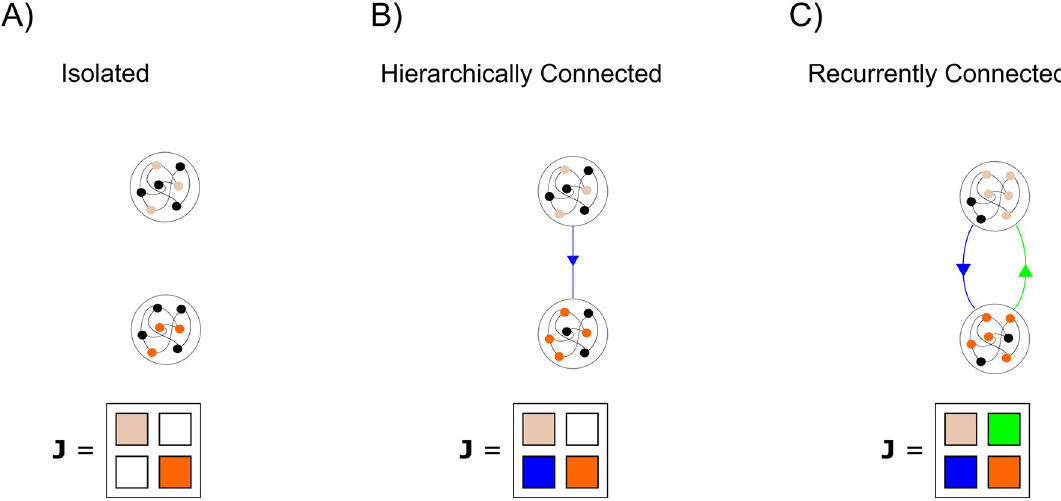
Fig 4. Cartoon illustrating the combination properties of contracting systems. A) Two isolated, contracting systems. The Jacobian of the overall system is block diagonal, with all zeros on the off-diagonal—corresponding to the fact that the systems are not connected. B) If one of the systems is connected to the other in a feedforward manner, the overall Jacobian is changed by the presence of non-zero terms on the bottom left block—corresponding to the connections going from the ‘top’ system to the ‘bottom’ system. This Jacobian may not be negative definite. However, it is known that a coordinate change exists which will make it negative definite. Thus, hierarchically connected contracting systems are contracting. C) If the systems are reciprocally connected, the system may lose its contracting properties (for example in the case of positive feedback). However, it is known that if the feedforward connections (blue) are ‘equal and opposite’ to the feedback connections (green) then the overall system is contracting. We use this property in the